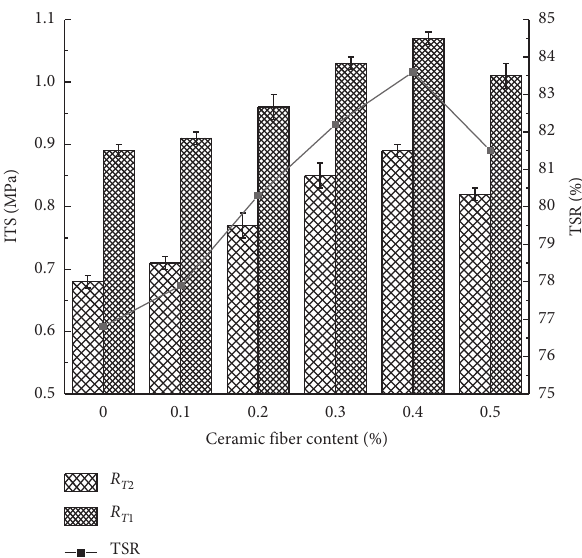
Figure 11: Results of the freeze-thaw splitting test.